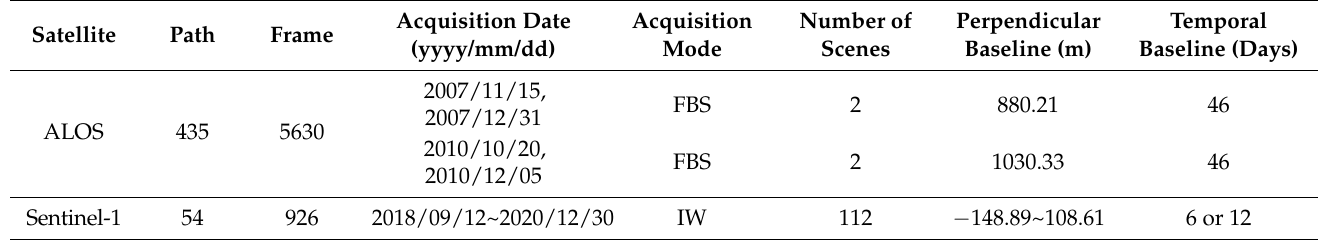
Table 2. SAR data used in this